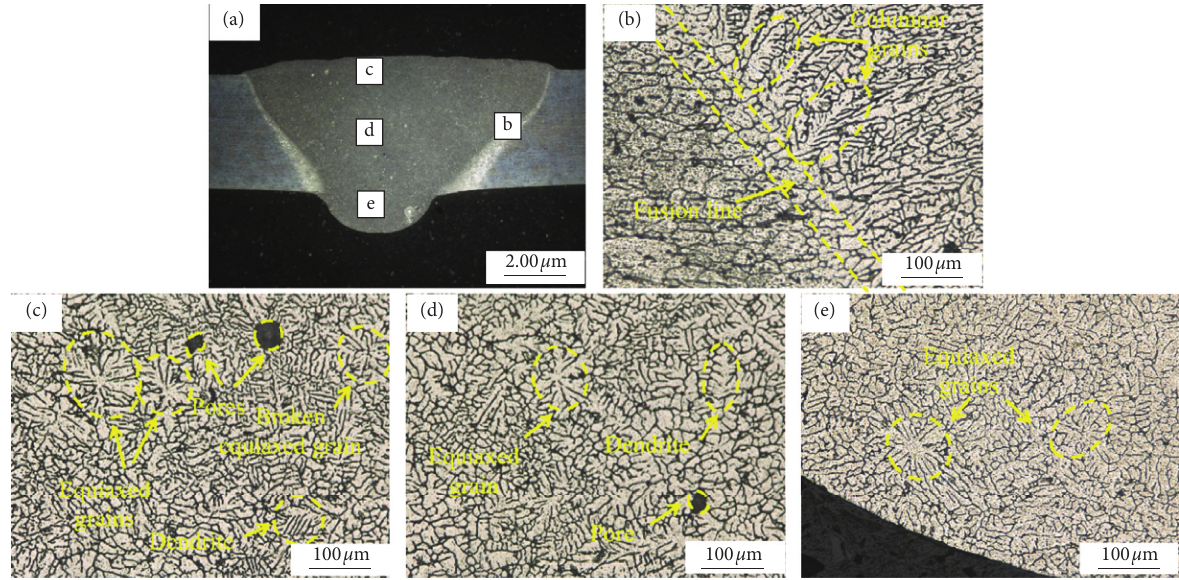
Figure 4: The morphology of WZ. (a) Macromorphology of WZ. (b) Microstructure of fusion zone. (c) Microstructure of the upper part of WZ. (d) Microstructure of the middle part of WZ. (e) Microstructure of the lower part of